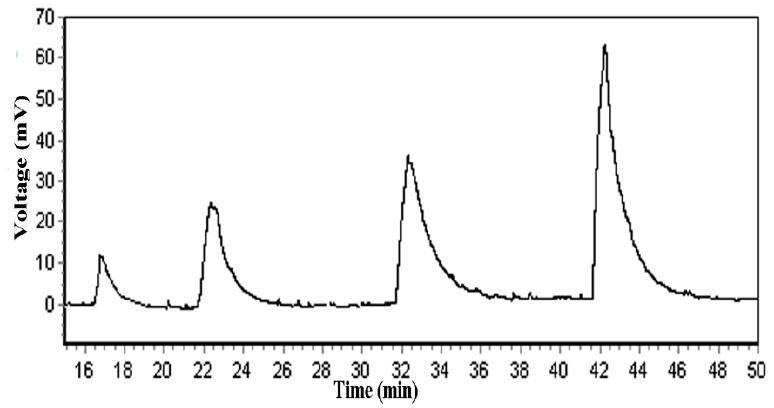
Figure 5. An actual sensor signal record for measurements of 50, 80, 100, and 200 mg/L COD